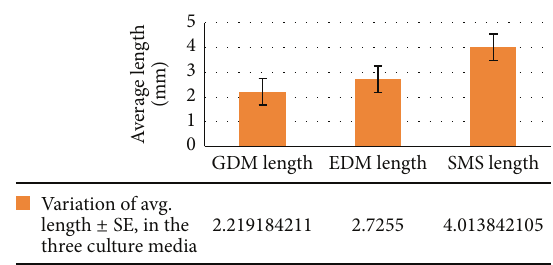
Figure 1: Variation of avg. length ± SE, in the three culture media.